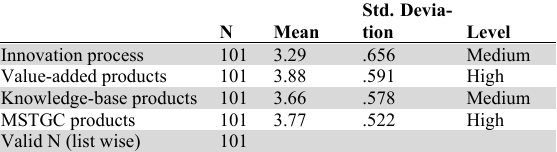
KM Mechanisms and Technologies´ Arithmetic Means and